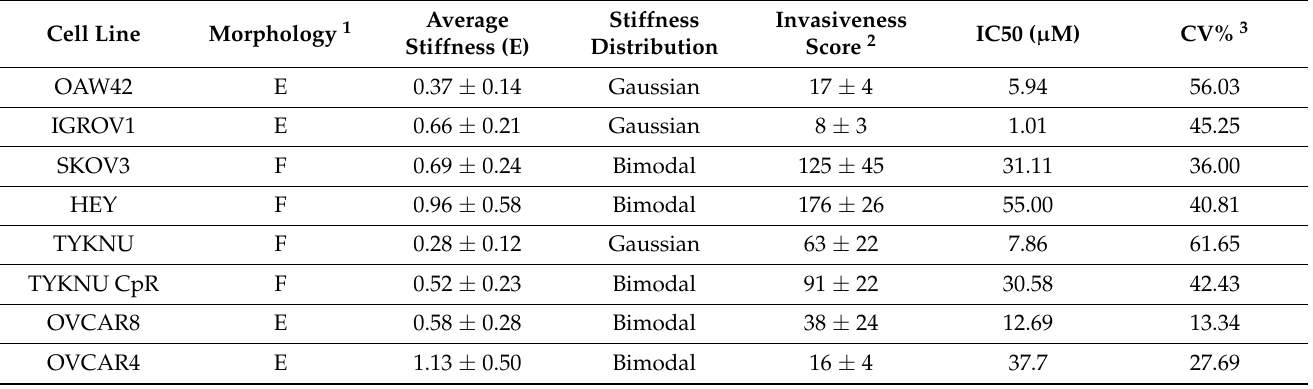
Table 1. Summary of biomechanical, invasiveness and 2c resistance features of the analyzed cell